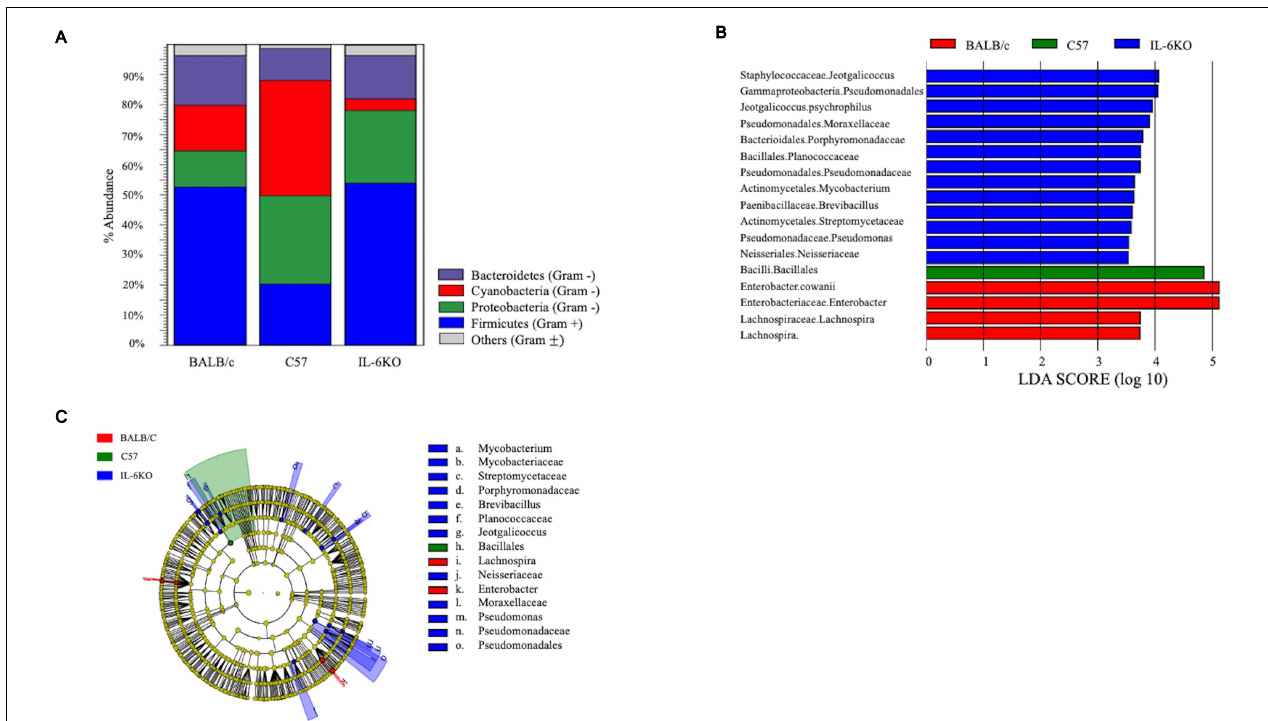
FIGURE 6 | Microbial community composition is altered in skin from various immunologically predisposed mouse strains. (A) 16S rRNA sequencing was performed on BALB/c, C57BL/6, and IL-6-deficient (KO) skin samples, and relative abundance of bacterial present on the skin is presented ( n = 6/experimental group). Taxonomy presented at the phylum level. (B) Linear discriminant effect size analysis (LEfSe) of the microbial communities showed significant ( p < 0.05) differences between the C57 and either BALB/c or the IL-6KO skin microbiomes with over 70% of the statistically relevant changes attributed to the altered IL-6KO community. Taxonomy is presented at the family level where known. The complete taxonomy and associated table are presented in Supplementary Figures 2, 3 , and Supplementary Table 1 . (C) The relevant differences in microbial communities are mapped upon a cladogram created using the LEfSe analysis. The largest number of statistically altered communities is mapped to the population associated with the IL-6KO (KO) ( p <